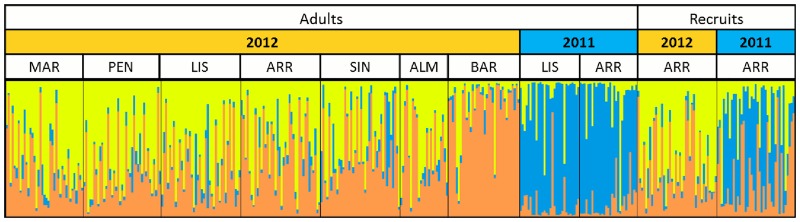
Averaged bar plot of STRUCTURE Bayesian clustering with K = 3.Vertical bars displayed for each individual show the estimated membership proportions in the three clusters colored in yellow, blue and orange. Populations are separated by black vertical lines and described by site abbreviations as in Fig 1, sampling year, and are divided in adult and recruit populations.